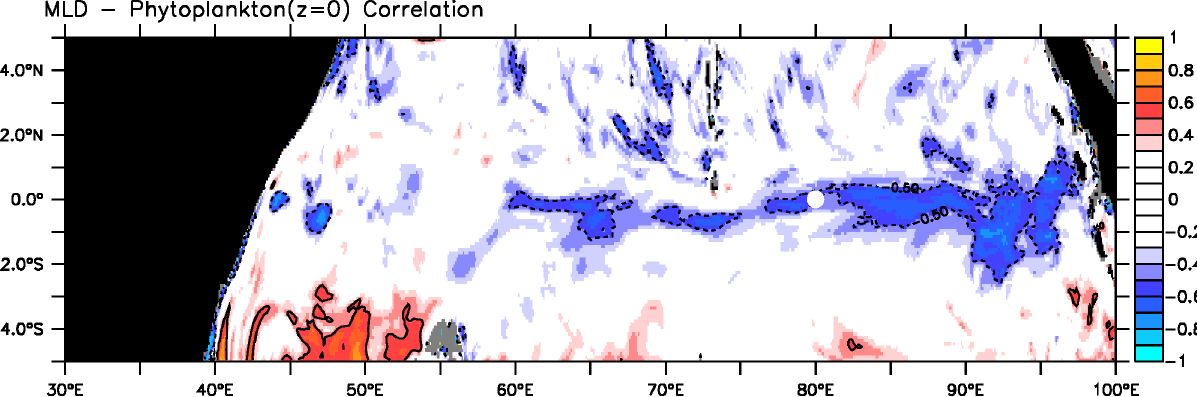
Figure 10. The correlation between mixed layer depth and phytoplankton concentration in the OFAM3 model. The mooring is marked with a white